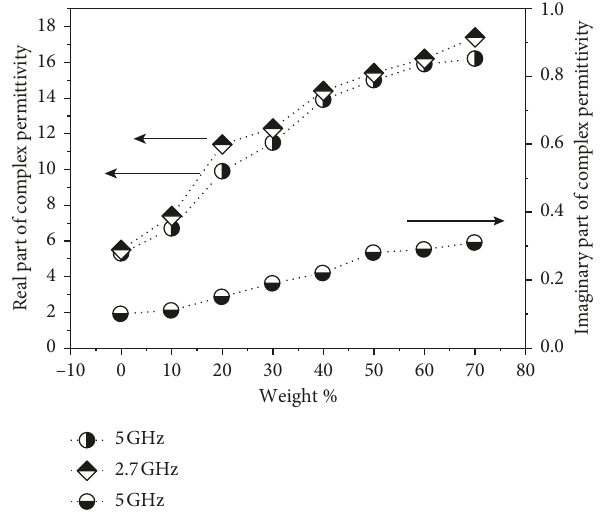
Figure 5: Real and imaginary parts of complex permittivity measured in 2.7GHz and 5GHz resonant cavity, for different weight fractions of CCTO.